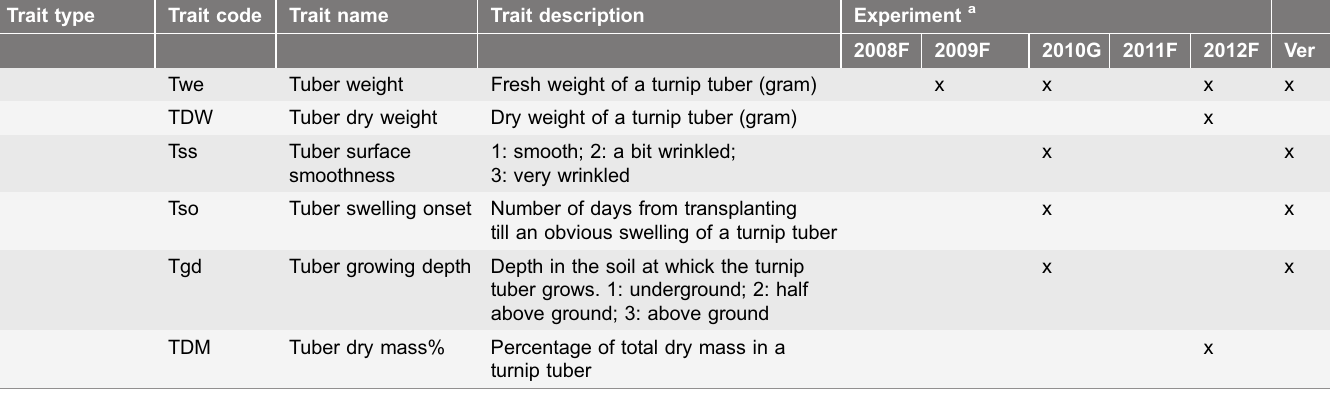
Table 2. Cont. Trait type Trait